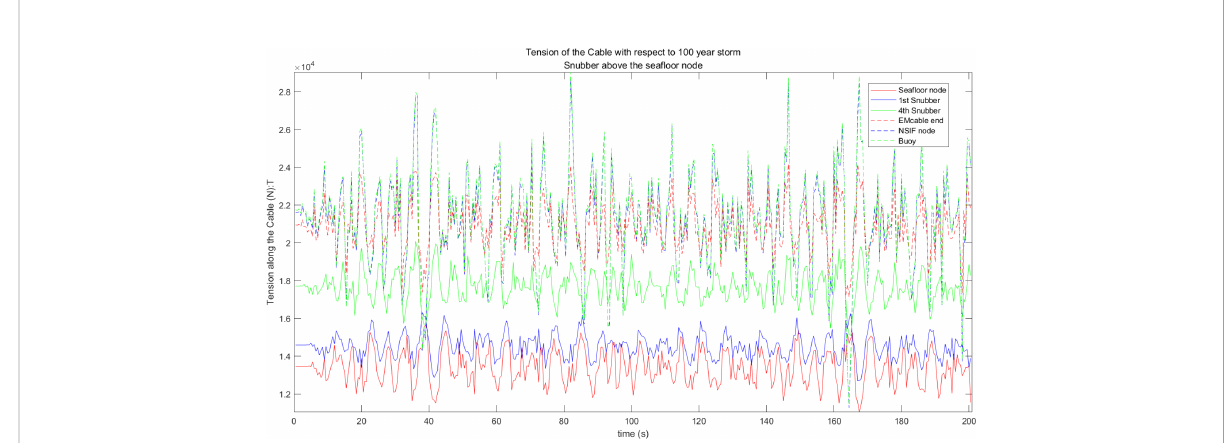
FIGURE 10 Dynamic tension for various components for a Nilspin cable with the snubber down.